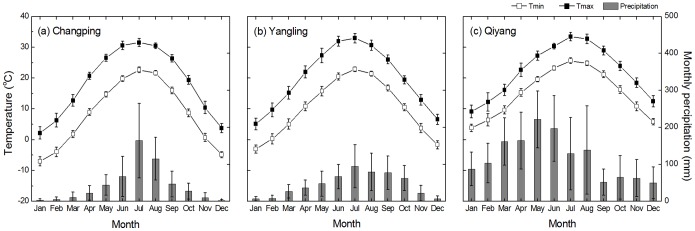
Average monthly precipitation, maximum (Tmax) and minimum (Tmin) temperatures from 1990 to 2010 at (A) Changping, (B) Yangling, and (C) Qiyang.Error bars are standard deviations for the mean values from 1990–2010.